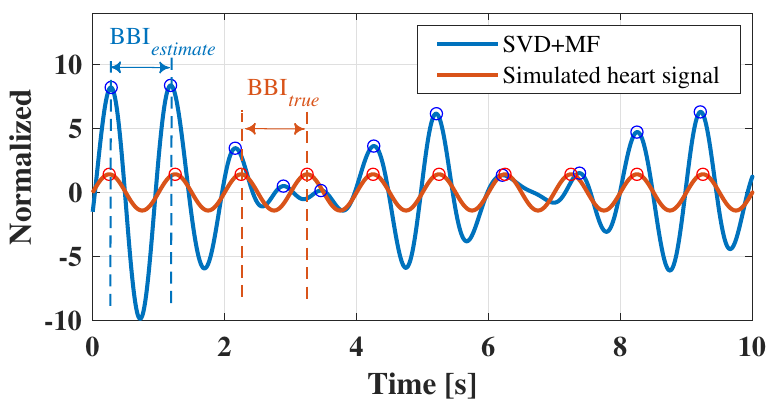
Figure 5. Example of a vibration model of a chest surface to which the proposed method was applied.